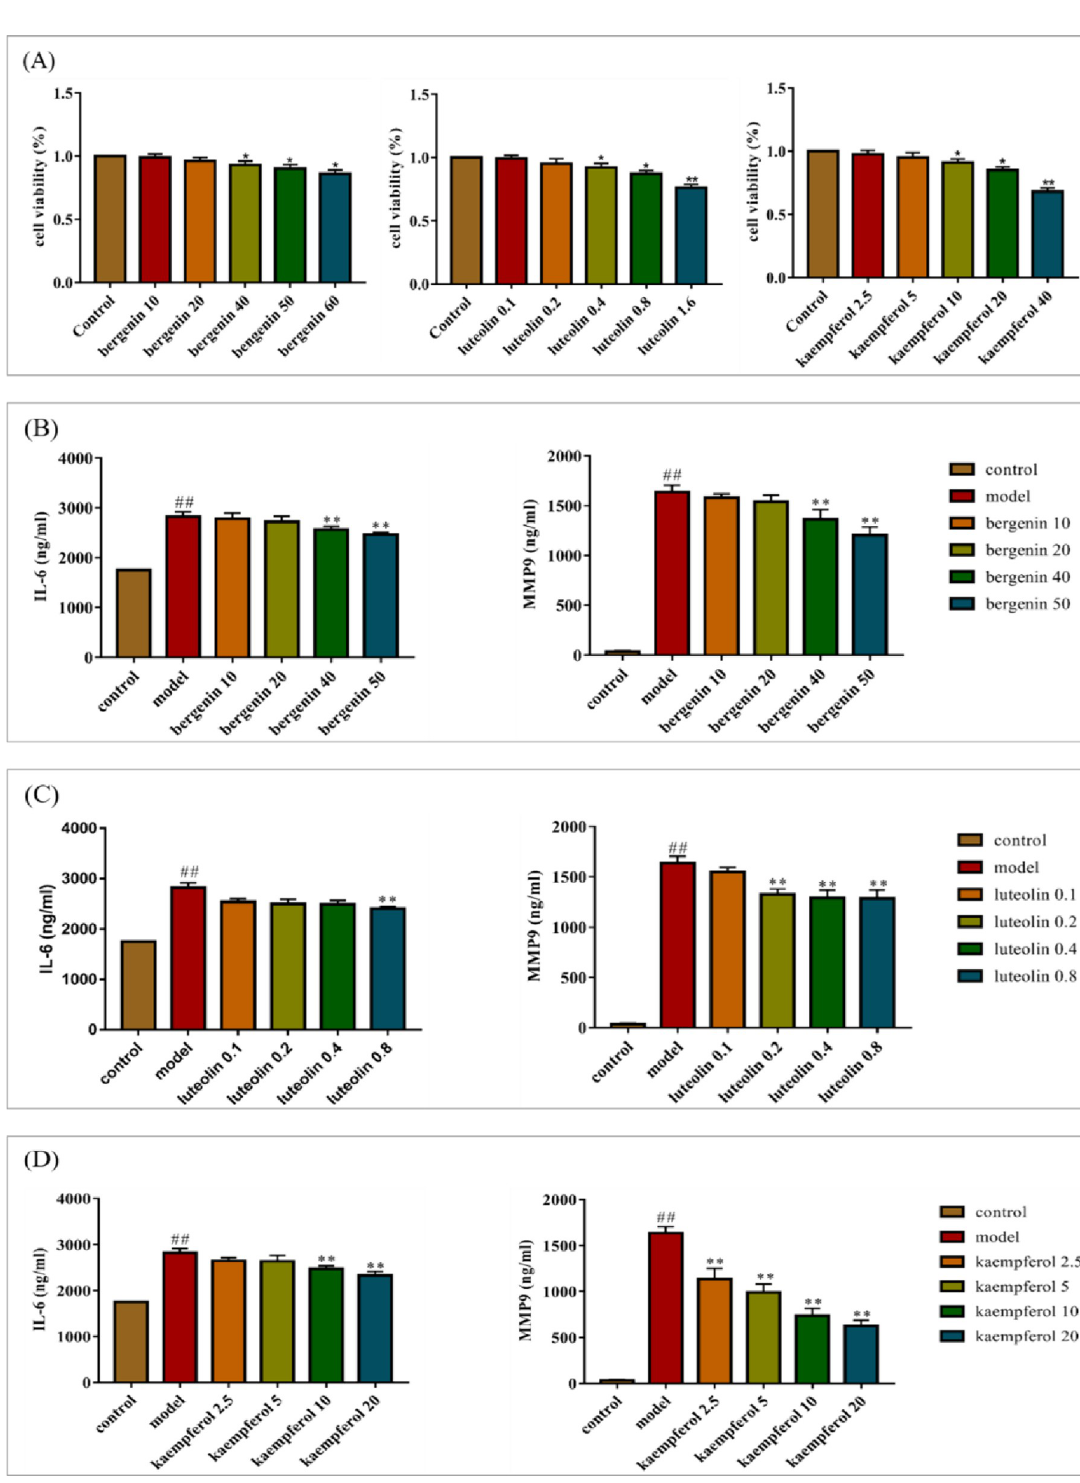
Fig 7. Effect of bergenin, luteolin, kaempferol on A549 cells. A: The effect of bergenin, luteolin, kaempferol on A549 cell viability were detected by MTT analysis. B-D: The effects of different concentrations of bergenin, luteolin, kaempferol on the contents of IL6, MMP9 in COPD model were determined by ELISA, respectively. Values represented as mean ± SD, n = 6. ## P < 0.01 versus control group. �� P < 0.01, � P < 0.05, versus model group.